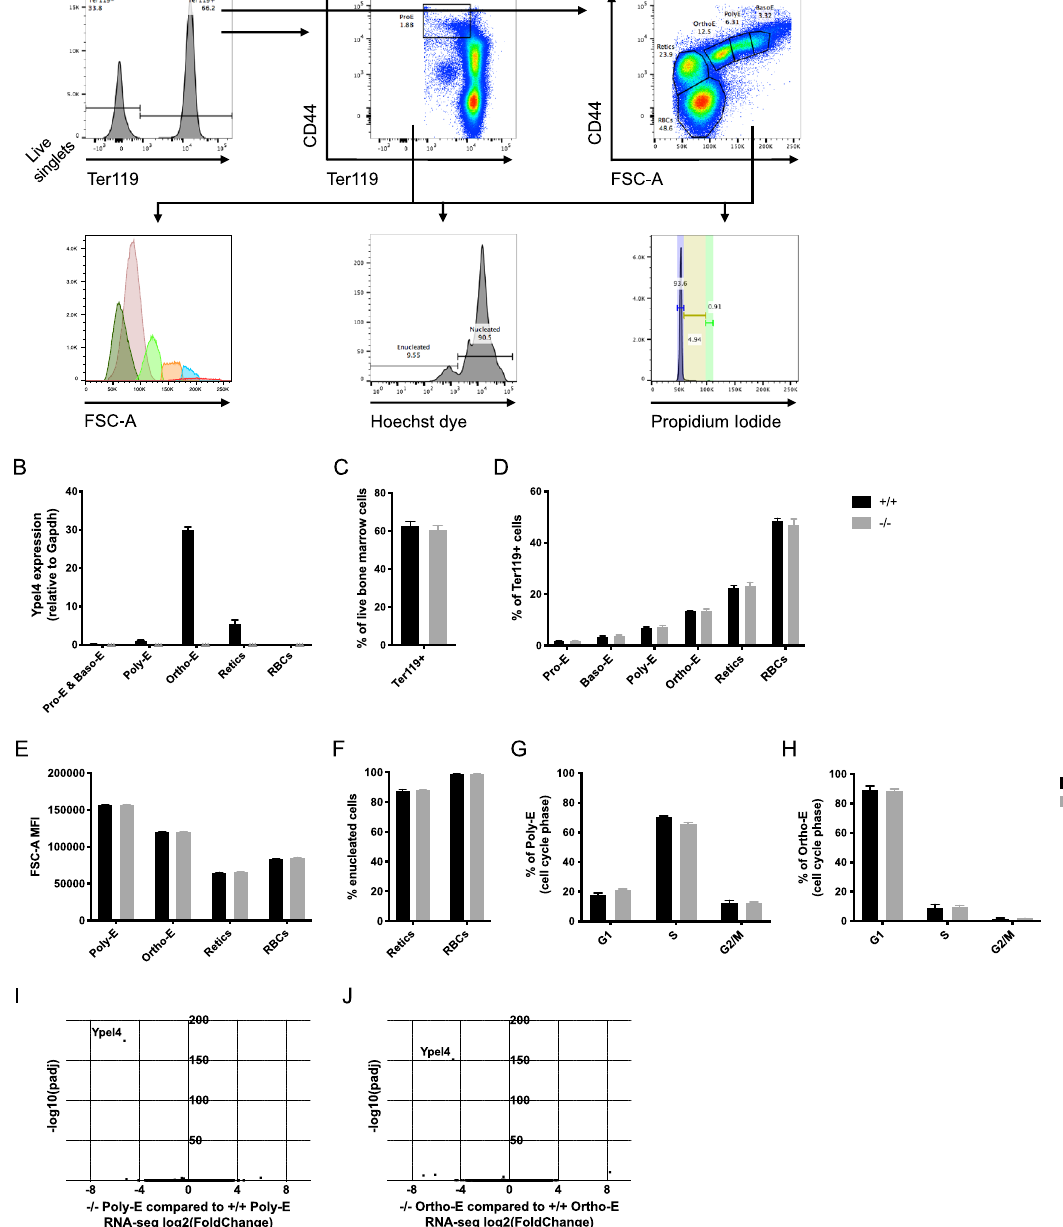
Figure 2. Ypel4 is upregulated during terminal erythropoiesis but deficiency does not affect normal erythroid precursor functionality in bone marrow. ( A ) FACS gating strategy for bone marrow (BM) terminal erythroid cell populations in wild-type (+/+) and Ypel4 -null (−/−) mice together with their forward scatter area (FSC-A) mean fluorescence intensity (MFI), Hoechst 33342 dye positivity and Propidium Iodide (PI) positivity after fixation. ( B ) Ypel4 quantitative Polymerase Chain Reaction (qPCR) expression relative to Gapdh in sorted subpopulations (n = 3). ( C ) Total live erythroid cell (n = 4) and ( D ) subpopulation frequencies in BM (n = 4). ( E ) FSC-A MFI measurements as approximations of cell size in Ypel4 -expressing subpopulations (n = 4). ( F ) Total enucleation efficiency as measured by lack of DNA staining using the cell-permeant Hoechst 33342 dye (n = 4). Cell cycle analysis by measurement of total DNA content (PI positivity) in the Ypel4 -expressing ( G ) Poly-E (n = 3) and ( H ) Ortho-E (n = 3) populations after fixation. RNA-sequencing was conducted on sorted ( I ) Poly-E (n = 4) or ( J ) Ortho-E (n = 4) populations and differential gene expression presented using log2(fold change) and − log10(padj). Data displayed as average ± SEM. Pro-E proerythroblast, Baso-E basophilic erythroblast, Poly-E polychromatic erythroblast, Ortho-E orthochromatic erythroblast, Retics reticulocyte, RBCs red blood cells, padj adjusted p